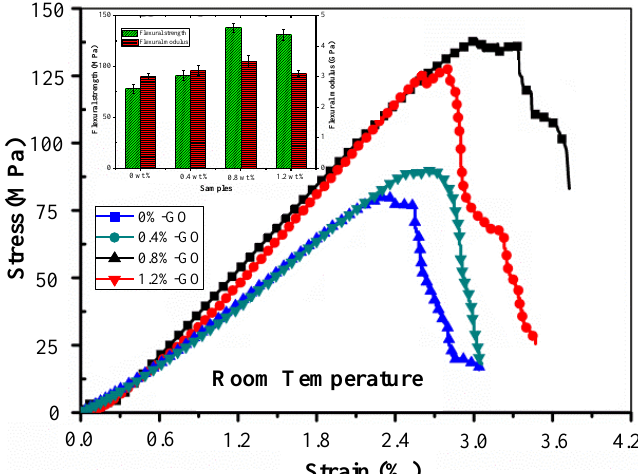
Figure 9. Flexural stress-strain curves of epoxy resin composite samples with different GO mass fractions at room temperature. Table 2. Flexural properties of nanocomposites with different GO content at room temperature.